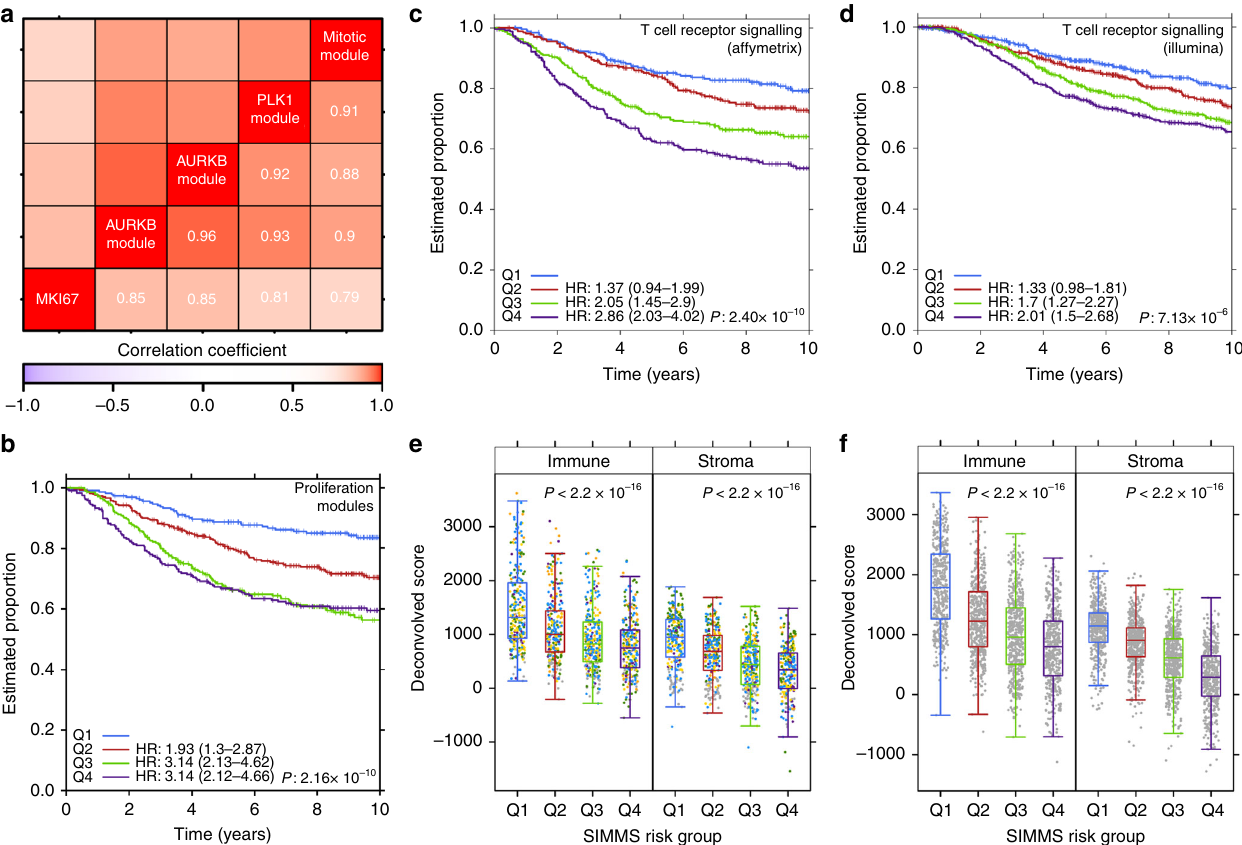
Fig. 2 Proliferation and immuno subnetworks. a Heatmap of correlation (Spearman) and cluster analysis of patient ’ s risk scores of proliferation modules in breast cancer, alongside mRNA abundance of a proliferation marker MKI67 . Ward ’ s method was used for hierarchical clustering. Data shown for validation cohorts. b Kaplan – Meier analysis of predicted proliferation scores (validation cohorts) using SIMMS-derived proliferation biomarker. Groups (Q1-Q4) were established using quartiles derived from the training set. Groups Q2-Q4 were compared to Q1 using Cox proportional hazards model. P value was estimated using Log-rank test assessing heterogeneity across the four groups. c Kaplan – Meier analysis of tumor immune microenvironment driver subnetwork (BioCarta pathway: T cell receptor signaling) in Affymetrix based validation cohorts. Quartile based risk groups (thresholds derived from training set), demonstrating linear increase in the likelihood of recurrence/event. Test statistics same as in b . d Kaplan – Meier analysis of tumor immune microenvironment driver subnetwork (BioCarta pathway: T cell receptor signaling) in Metabric breast cancer cohort (Illumina platform). e Assessment of computationally inferred immune system in fi ltration and stromal estimates against SIMMS predicted risk groups (Q1-Q4 i.e., low to high) in Affymetrix validation cohorts (test statistic: ANOVA P value). Color of dots represent respective validation cohort (Supplementary Table 2). f Same as e